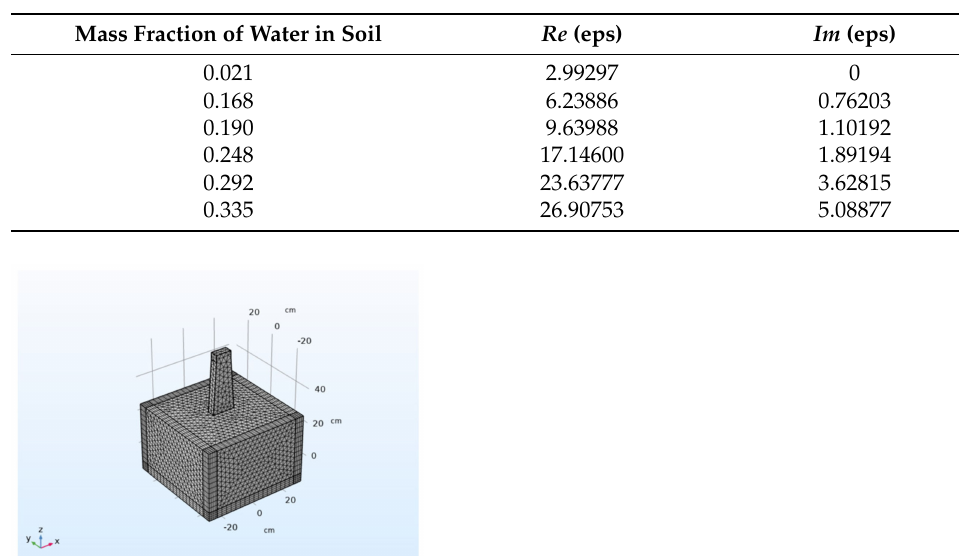
Table 2. Parameter settings of the real ( Re (eps)) part and imaginary part Im (eps) of the soil dielectric constant during the simulation.